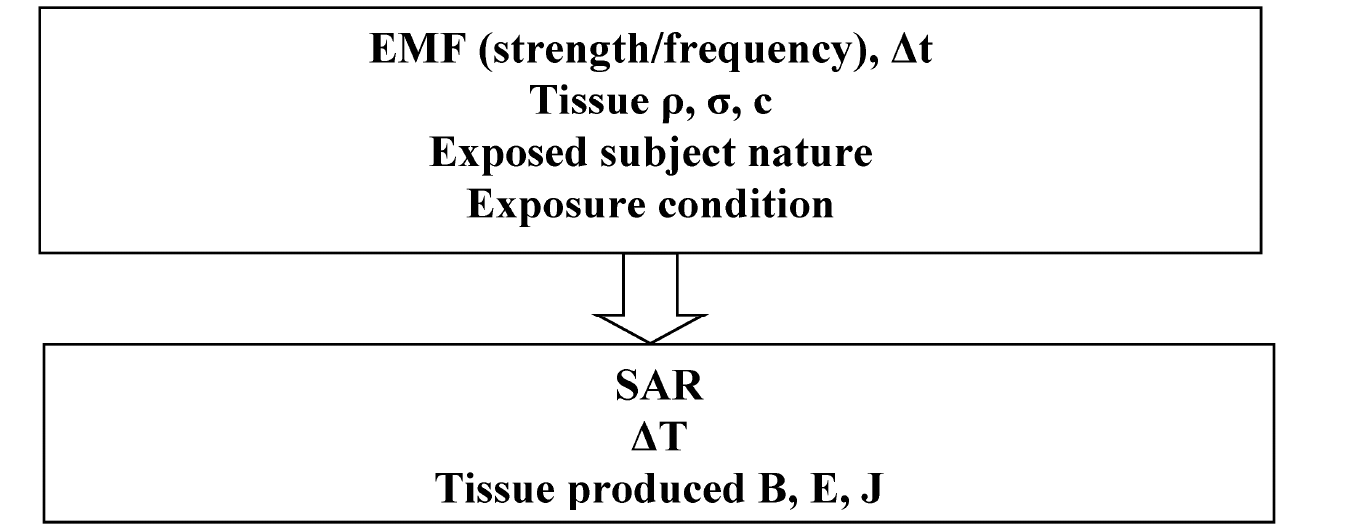
Figure 2. Input EMF exposure (parameters, nature and condition) and output effects on tissue.